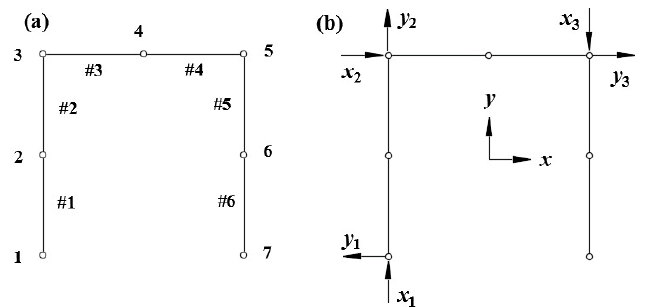
Figure 1. ( a ) The element division of the gantry structure; ( b ) the local and global coordinate systems of the gantry structure.